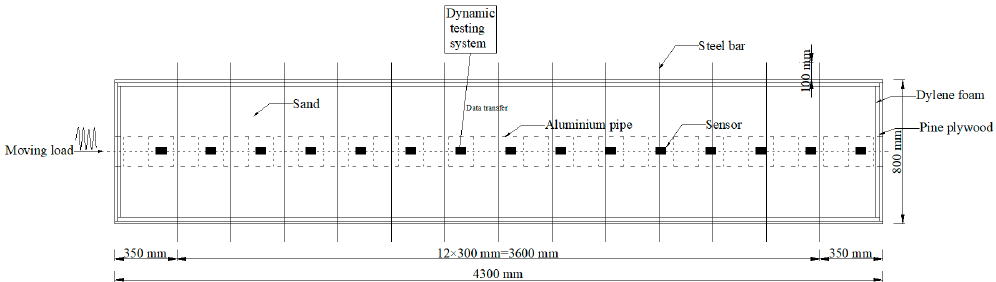
Figure 2. Experimental setup for dynamic tests of aluminum pipe model.